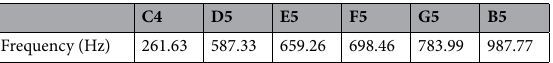
Materials and methods